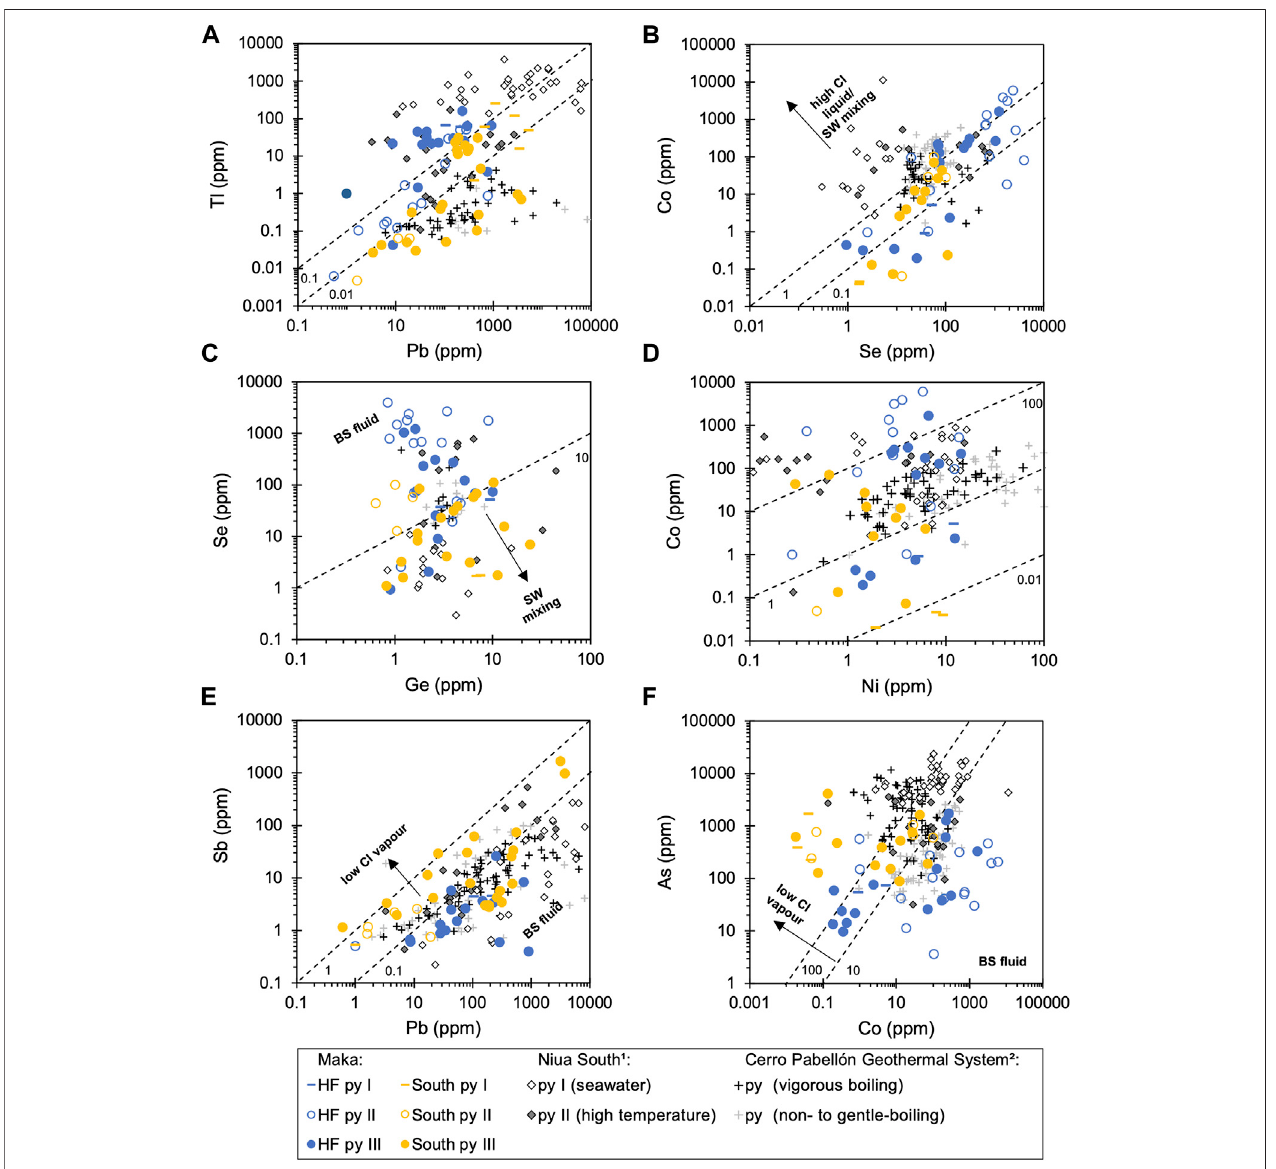
FIGURE4| Bivariatetraceelementdiagramsof (A) Tl – Pb, (B) Co – Se, (C) Se – Ge, (D) Co – Ni, (E) Sb – Pb, (F) As – CoinpyritefromMakaHFandMakaSouth.The dashedlinesrepresentthetraceelementratiosoftherespectiveelementsinthediagram(e.g.,Tl/PbinA).Superscripts:1 (cid:1) (Falkenbergetal.,2021),2 (cid:1)